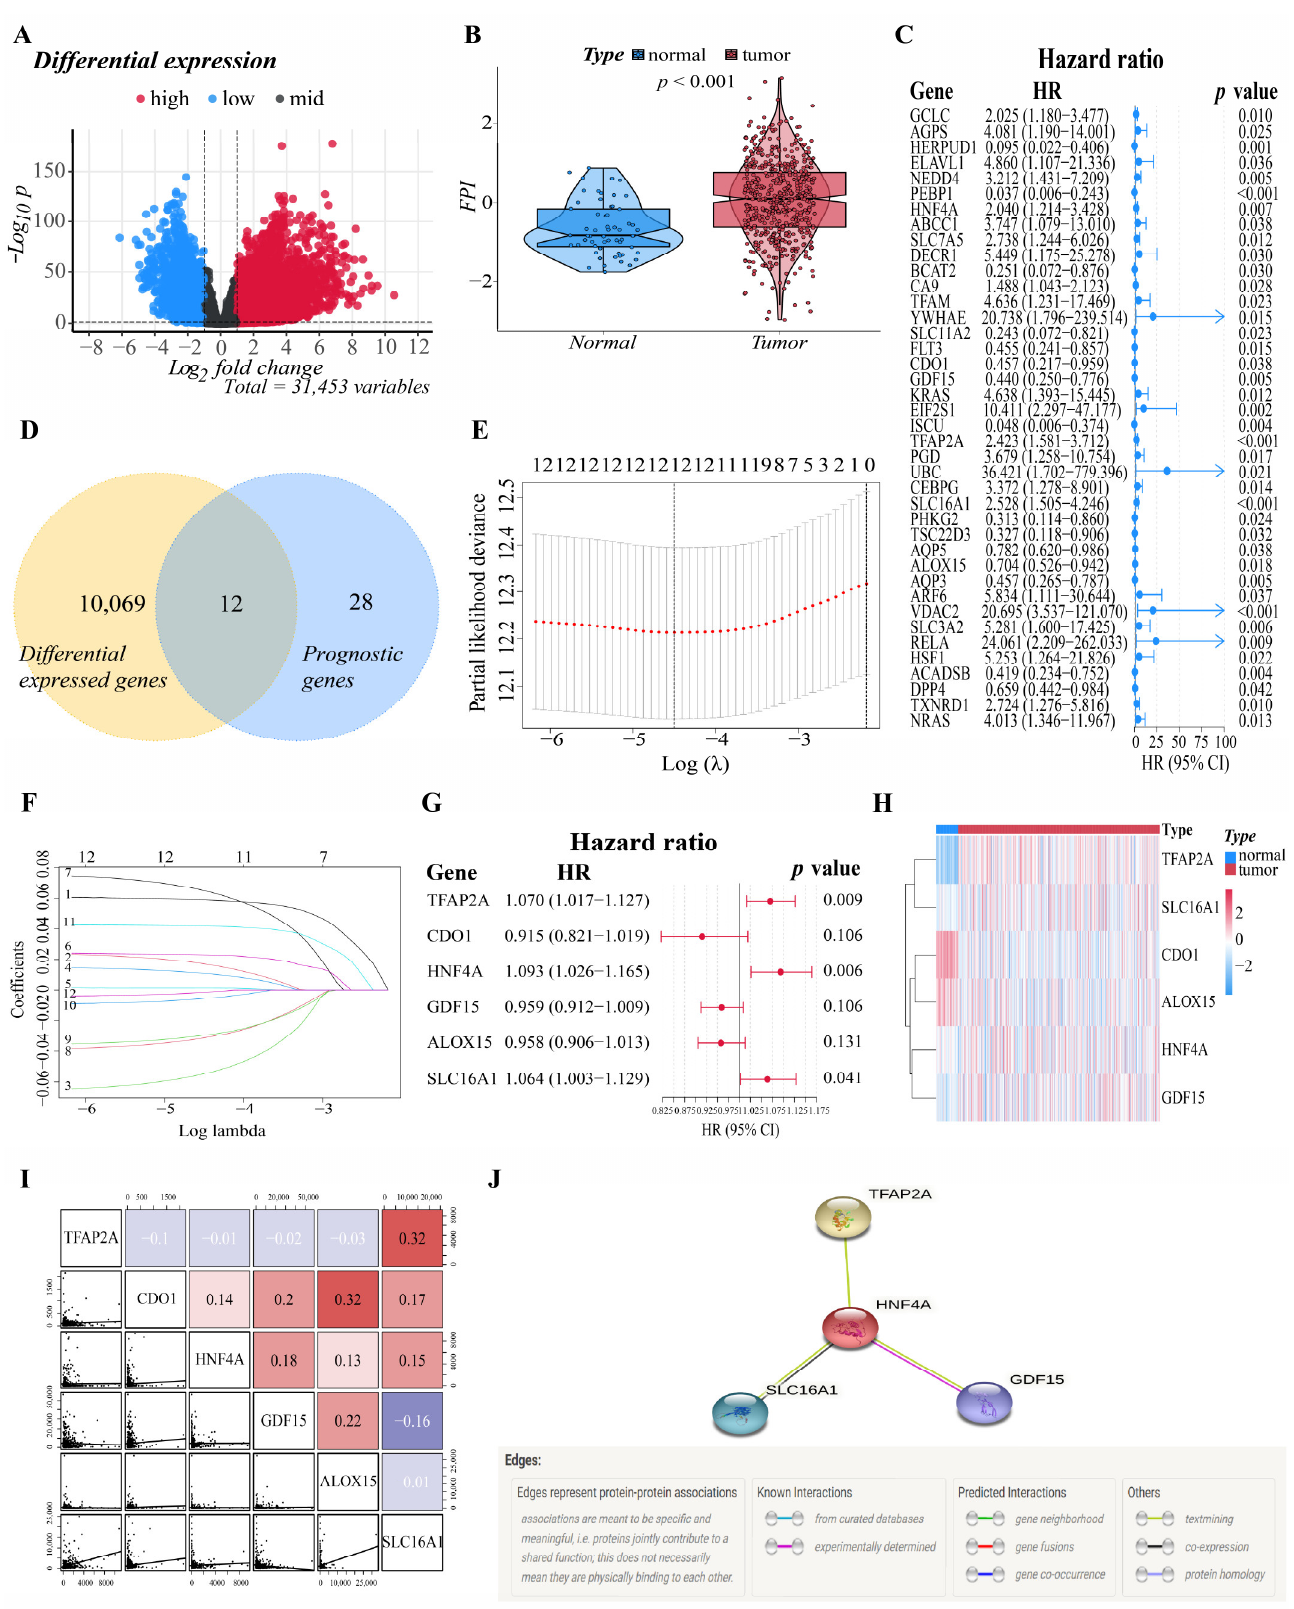
Figure 1. Establishment of the six-gene signature related to ferroptosis. ( A ) The distribution of downregulated and upregulated DEGs is depicted by a volcano map. Blue, black, and red represent the low, equal, and high expression of genes in the relevant group, respectively. The X-axis